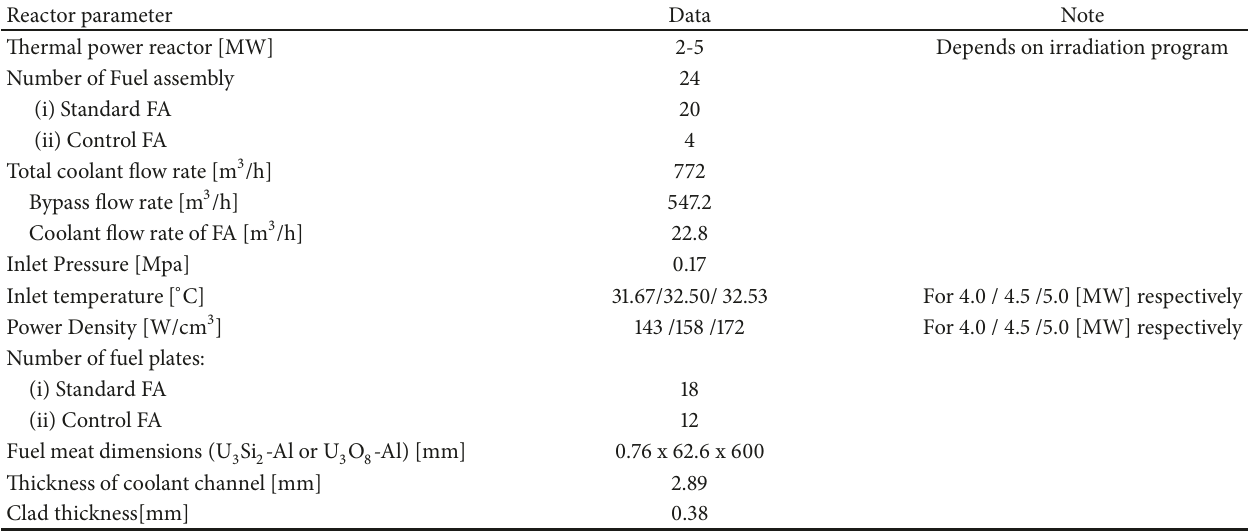
Table 5: Main description parameters of IEA-R1 research reactor [22, 26].